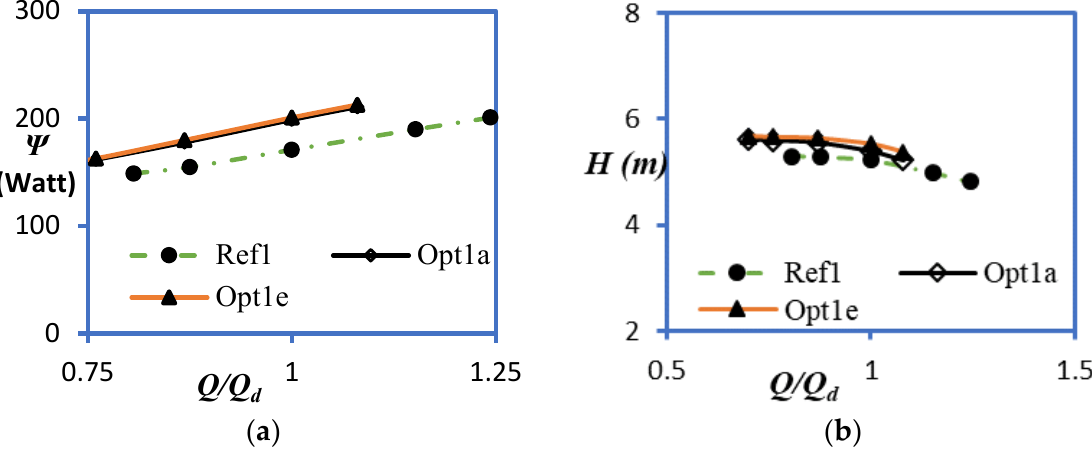
Figure 15. Pump performance comparison for water: ( a ) Ψ versus Q/Qd and ( b ) H versus Q/Qd.